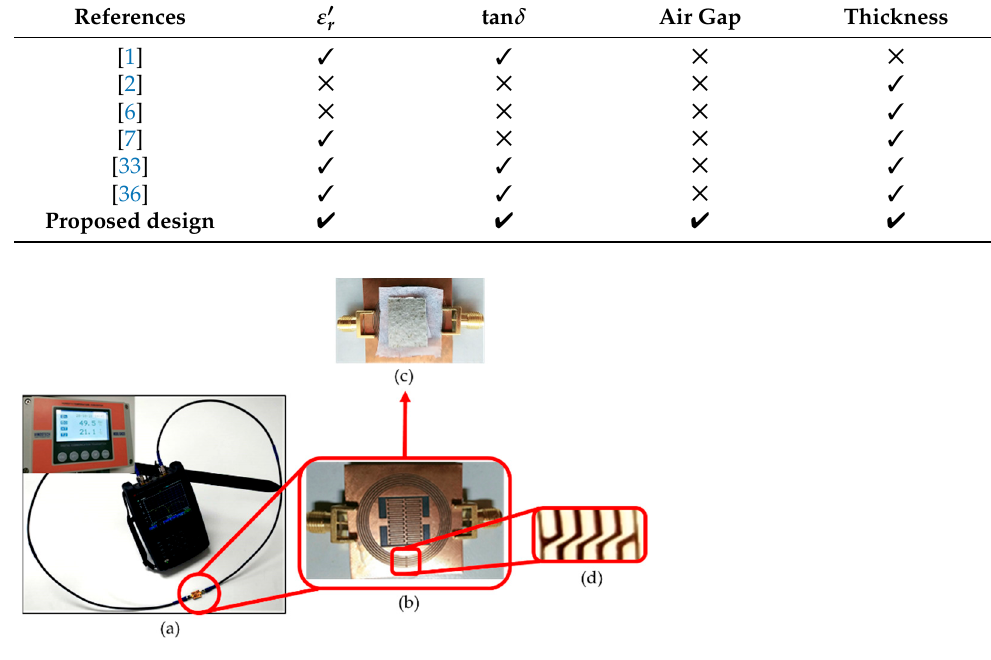
Figure 9. Measurement setup of the proposed design: ( a ) designed sensor under testing; ( b ) back view of the designed sensor; ( c ) polypropylene strips between designed microwave sensor and MUT; ( d ) fabricated bridge-type structure.